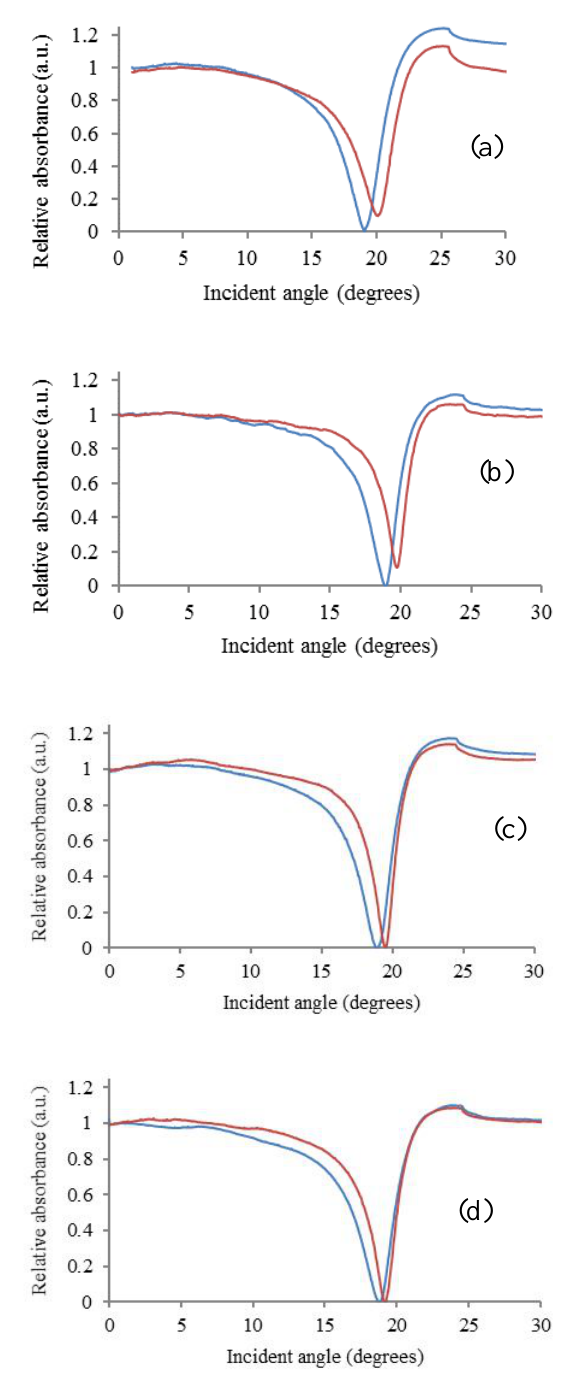
Fig. 2. SPR response of the sputtered thin silver films (50 nm) silanized with APTES and condensate in NaOH solution for 5 (a), 15 (b), 30 (c) and 60 min